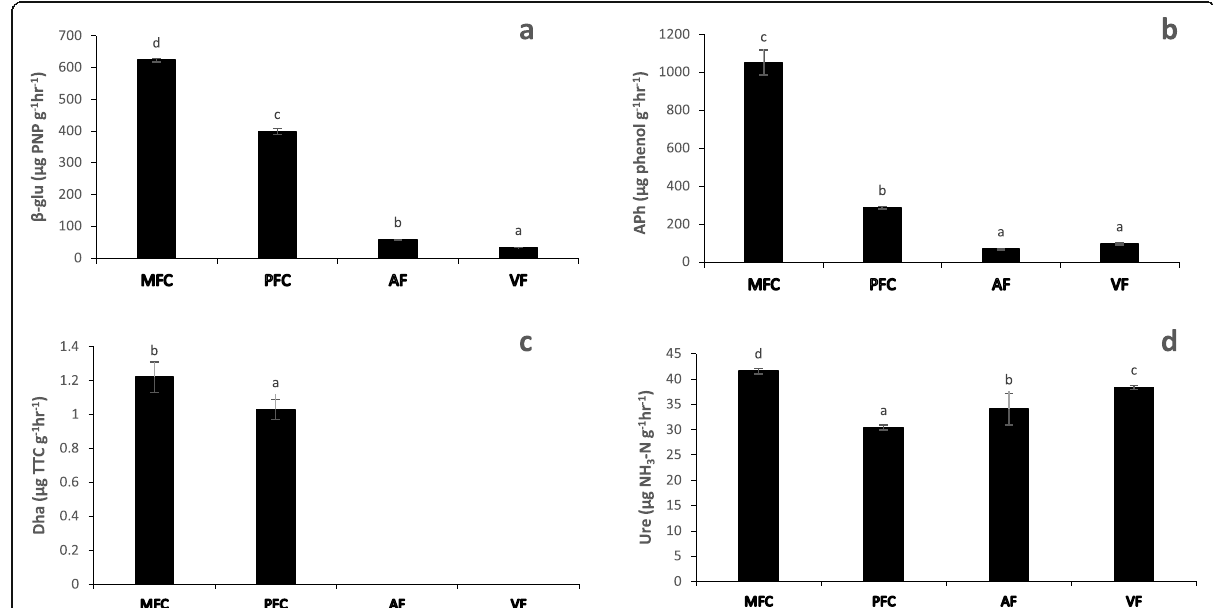
Fig. 3 Soil enzyme activity under different land uses. Soil β -glu ( a ), APh ( b ), Dha ( c ), and Ure ( d ) activities. Mean values with different letters are significantly different between land use ( P < 0.05; Tukey ’ s test at ⍺ = 0.05). Error bars represent the standard error of the mean. Note: β -glu β -